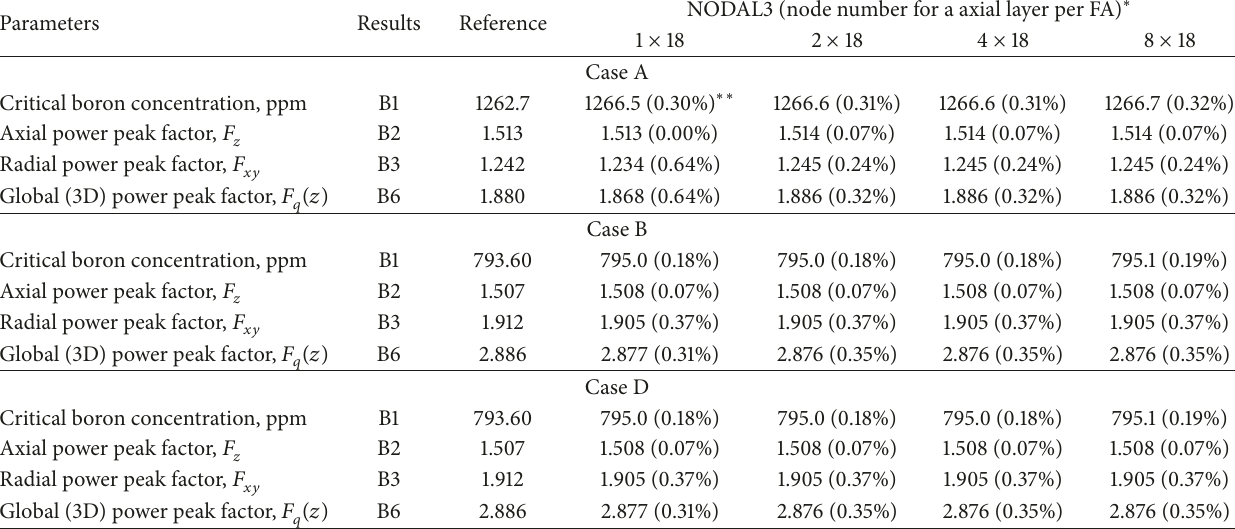
Table 3: Effect of axial node number per FA for steady-state parameters in Cases A, B, and D.